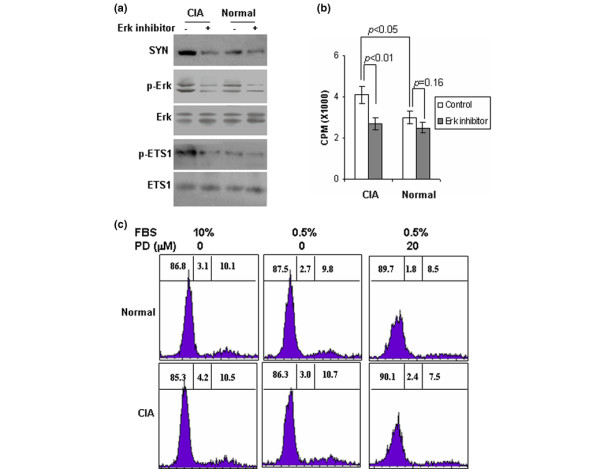
Erk inhibition suppresses ETS1 activation and hyperproliferation of mouse synovial fibroblasts from collagen-induced arthritis (CIA) mice. (a) Synovial fibroblasts isolated from CIA or normal mice were cultured without or with Erk inhibitor. The expression of Synoviolin (SYN) was determined by Western blotting by using anti-SYN antibody (top panel). The activation and protein levels of Erk in the parallel prepared cell lysates were detected by anti-phospho-Erk and anti-Erk, respectively (the second and third panels). Similarly, the activation and protein levels of ETS1 in the parallel prepared cell lysates were detected by anti-phospho-ETS1 and anti-ETS1, respectively (the bottom two panels). (b) Synovial cells were cultured without or with Erk inhibitor in 12-well plates for 24 hours. One microcurie of 3H-tymidine was added to each well of plated cells and further cultured for 16 hours. 3H-tymidine incorporation was analyzed as described previously [18]. Error bars represent three independent experiments (mean ± standard deviation). (c) Cell cycle analysis of Erk inhibitor-treated synovial fibroblasts. Cells treated with or without the Erk-specific inhibitor were collected and fixed in cold methanol and then stained with propidium iodide (PI) in the presence of RNase. PI-stained cells were washed once with phosphate-buffered saline and then analyzed by flow cytometry. The cell death was significantly increased when CIA synovial fibroblasts were treated with Erk inhibitor, PD98059 (PD). CPM, counts per minute; Erk, extracellular signal-regulated kinase; FBS, fetal bovine serum.